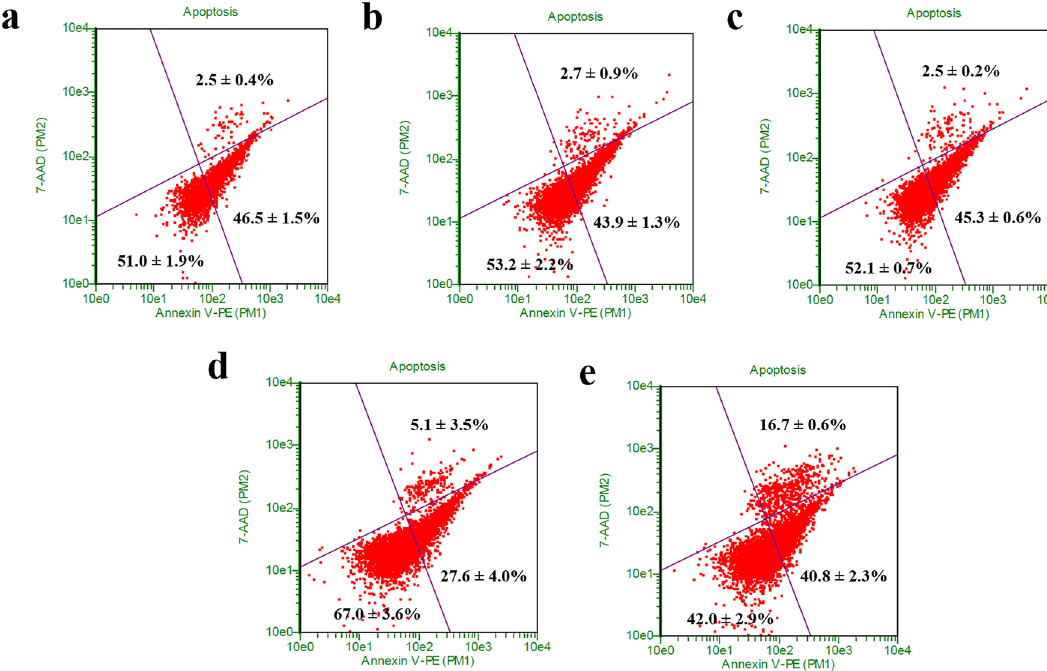
Figure 4. Cytotoxicity studies of ( a ) F2 Gtn-Tyr hydrogel-only, ( b ) siScramble loaded Gtn-Tyr hydrogel and ( c ) siSPARC loaded Gtn-Tyr hydrogel as compared to controls (d) untreated cells and ( e ) apoptosis-induced cells. After treated for 7 days, C57Bl6/J MTFs were stained by Guava Nexin reagent containing 7-AAD/Annexin- V-PE and analysed by flow cytometry. In the four windows of each plot, the lower-left indicates healthy cells, the lower right indicates early apoptotic cells, and the upper right indicates late-phase apoptotic cells or necrotic